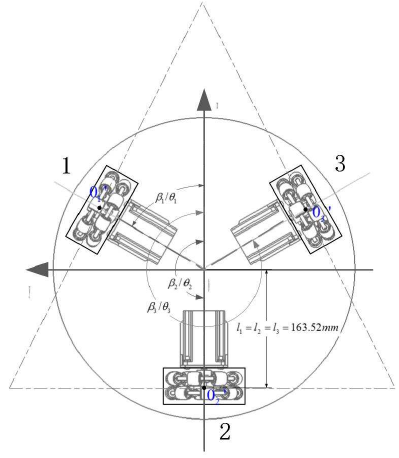
Figure 6. Three-wheeled structure layout of the platform. Table 1. The parameters of system